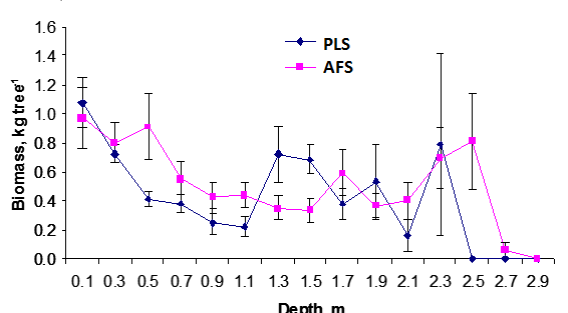
Fig. 6. Fine root biomass at different depth in AFS and PLS (FRS)